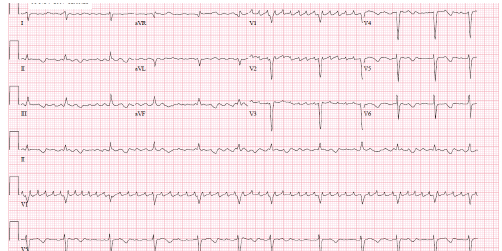
Figure 1: Baseline EKG. Normal sinus rhythm with a short PR interval.